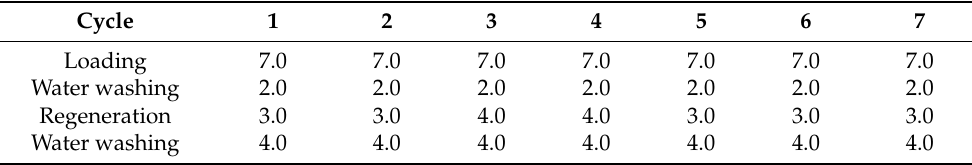
Table 2. Feed volumes ( V F in BV) used in the pilot-scale ammonium removal